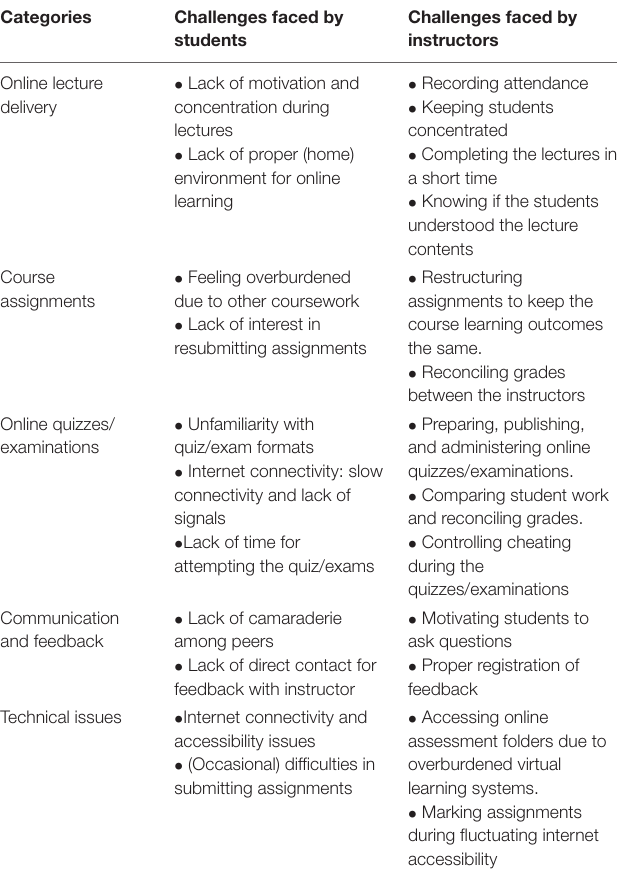
TABLE 5 | Summary of key challenges identified by the students and